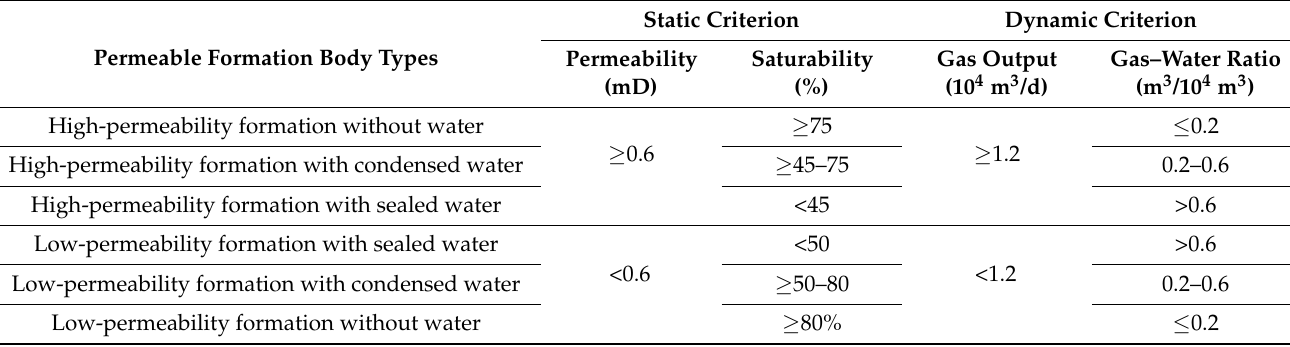
Table 3. The dynamic and static classification standard of permeable formation